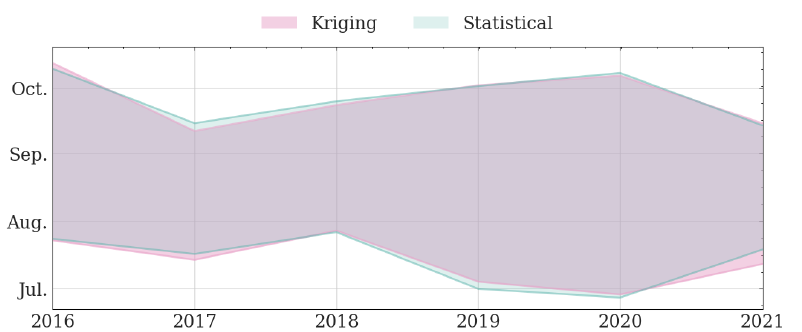
Figure 23. Comprison of 80% ice-free transit navigation window utilizing SICs from statistical and kriging